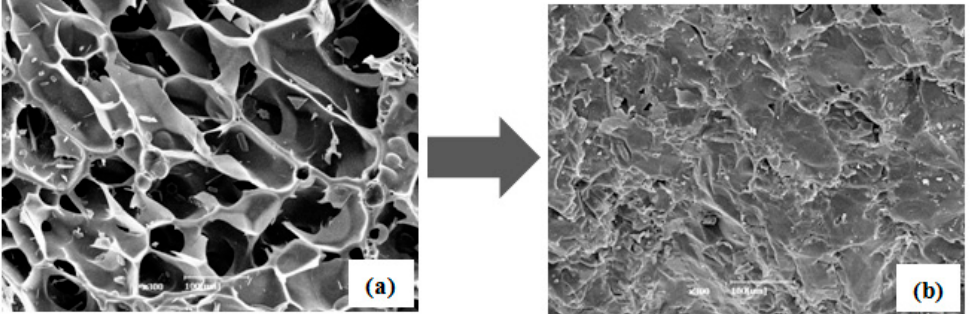
Figure 6. Cont. Figure 6. Cont